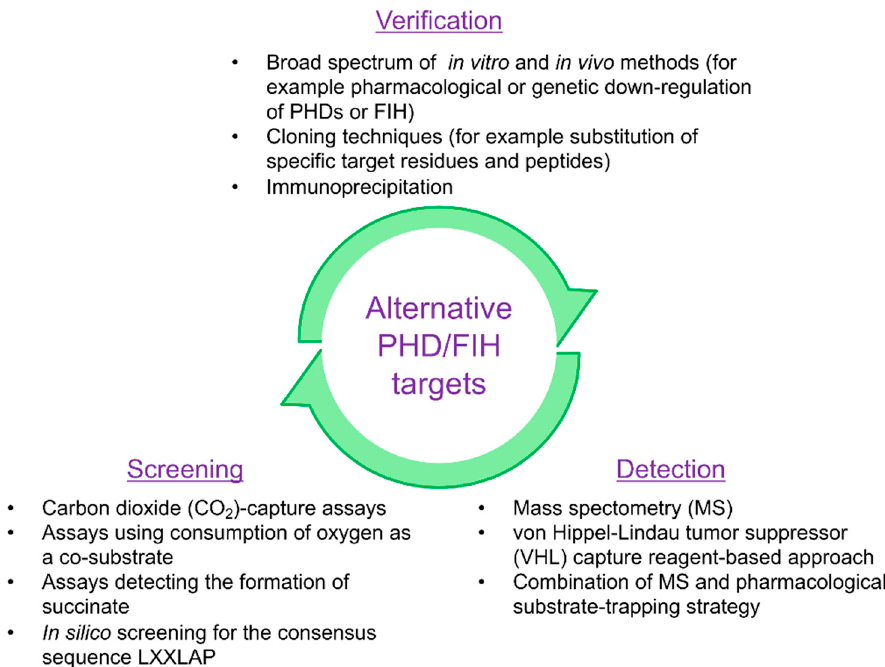
Figure 3. Overview of different techniques and methods to screen, detect and verify alternative targets and substrates of HIF prolyl hydroxylases (PHDs) and factor-inhibiting HIF (FIH).